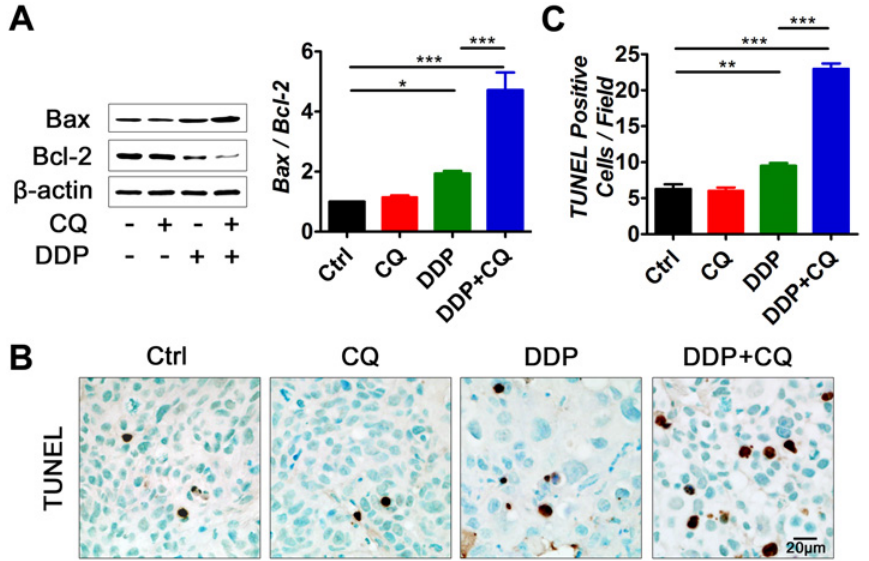
densitometric analysis of the Western blot bands (7 animals per group). (B) Representative TdT-mediated dUTP nick end labeling (TUNEL) staining of tumor tissues, scale bar = 20 μ m. (C) The average numbers of TUNEL-positive cells per field in each group. Cells were counted in 10 randomly selected fields in 7 tumor samples from each group. The values represent the mean ± SEM. * p < 0.05, ** p < 0.01, *** p < 0.001.